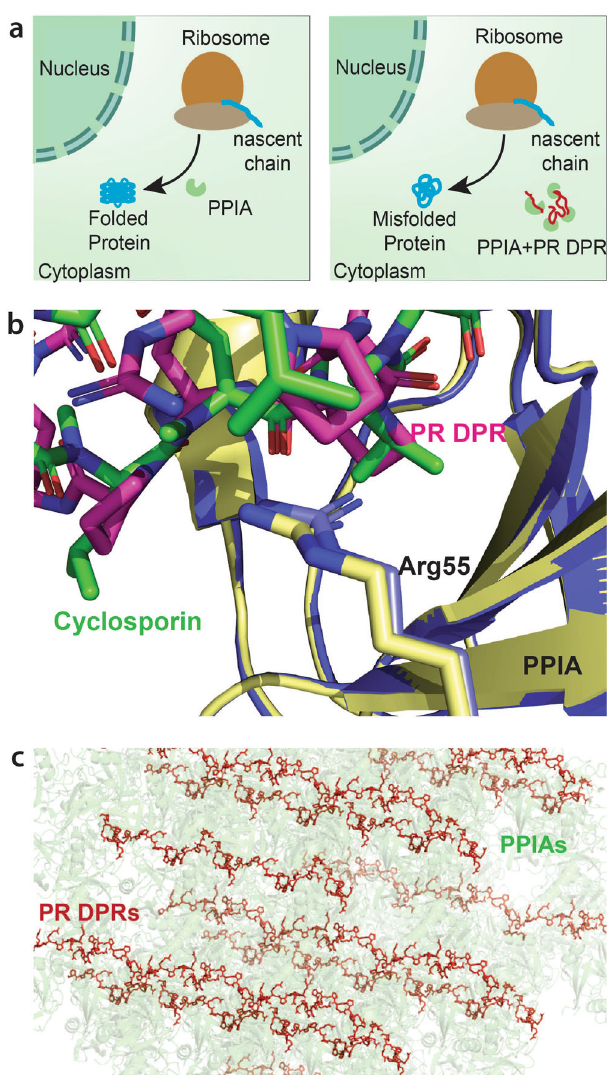
Fig. 4 Inhibition and sequestration of prolyl isomerases by C9ORF72 ALS/FTD-associated PR repeat polymers. a In normal conditions not associated with disease, prolyl isomerases such as PPIA catalyze the cis – trans isomerization of prolyl peptide bonds and thus help proteins to fold when they exit from the ribosome. PR dipeptide repeat polymers (DPR; red chains) translated from hexanucleotide repeat expansion in the non-coding region of the C9ORF72 gene, bind to the active site of prolyl isomerases and thus block their ability to catalyze protein folding. b Comparison of the active site of the prolyl isomerase PPIA (blue/yellow) in complex with the immunosuppressant drug cyclosporin A (green; PDB code: 1CWA; https:// www.wwpdb.org/pdb?id = pdb_00001cwa 38 ) and a PR repeat polymer (pink). c Crystal lattice of the PPIA/PR20 complex illustrating the dense packing of PPIases (green) that is possible on long PR dipeptide repeat polymers (DPR,